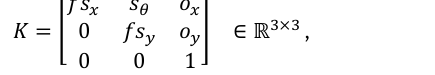
position of the optical center ( ), the size of the pixel ( ), its skew factor , and the focal length f . The matrix K